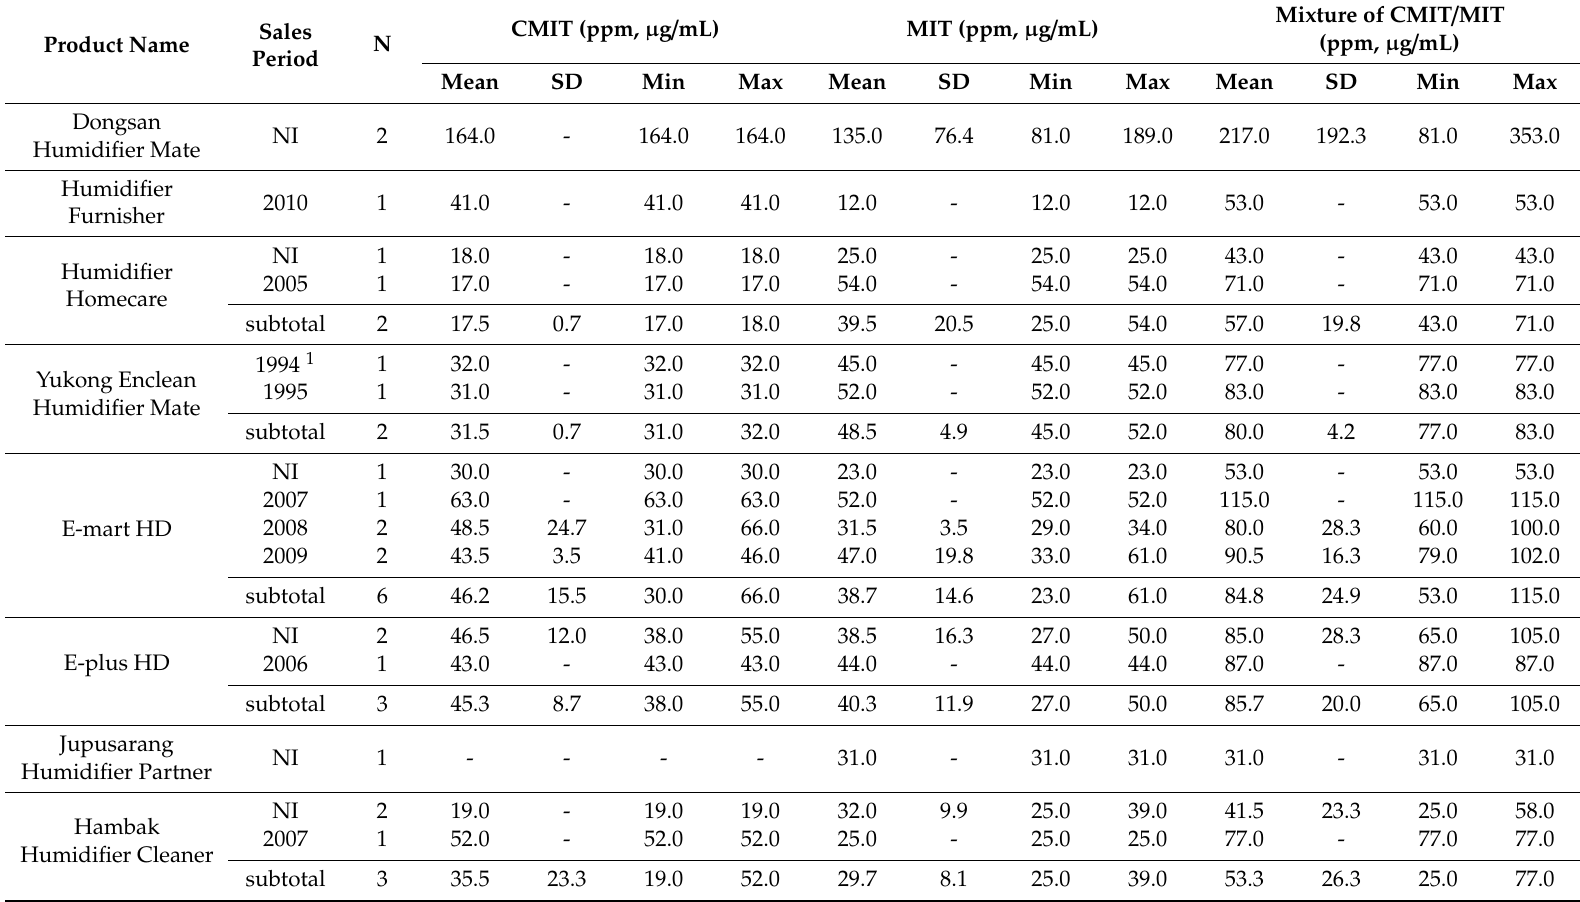
Table 3. The level of CMIT and MIT by year manufactured and humidifier